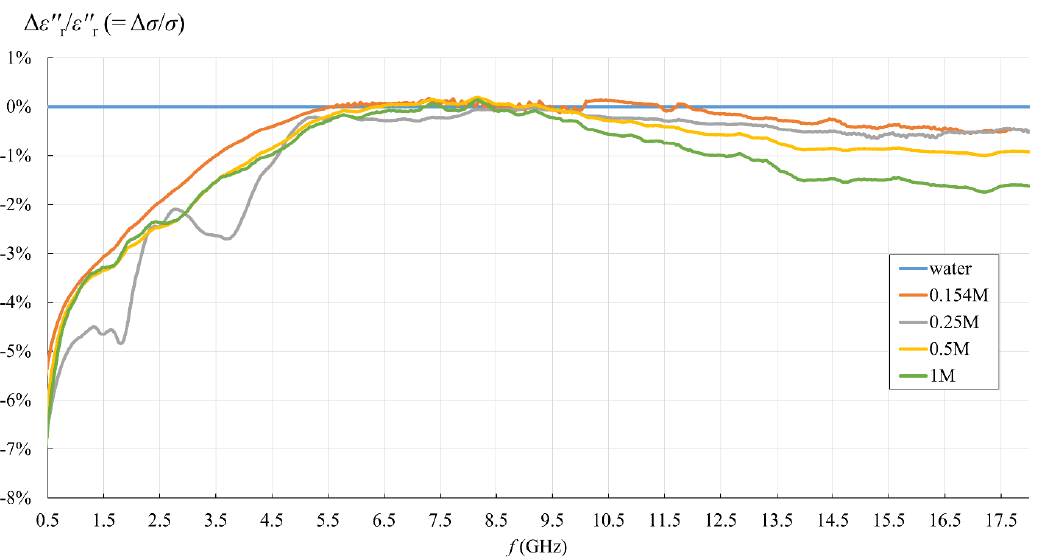
Figure 12. 𝜀 r″ relative error of the simple capacitive-load model with respect to the measurement result obtained from the measurement software, for water and saline solutions with different NaCl concentrations .